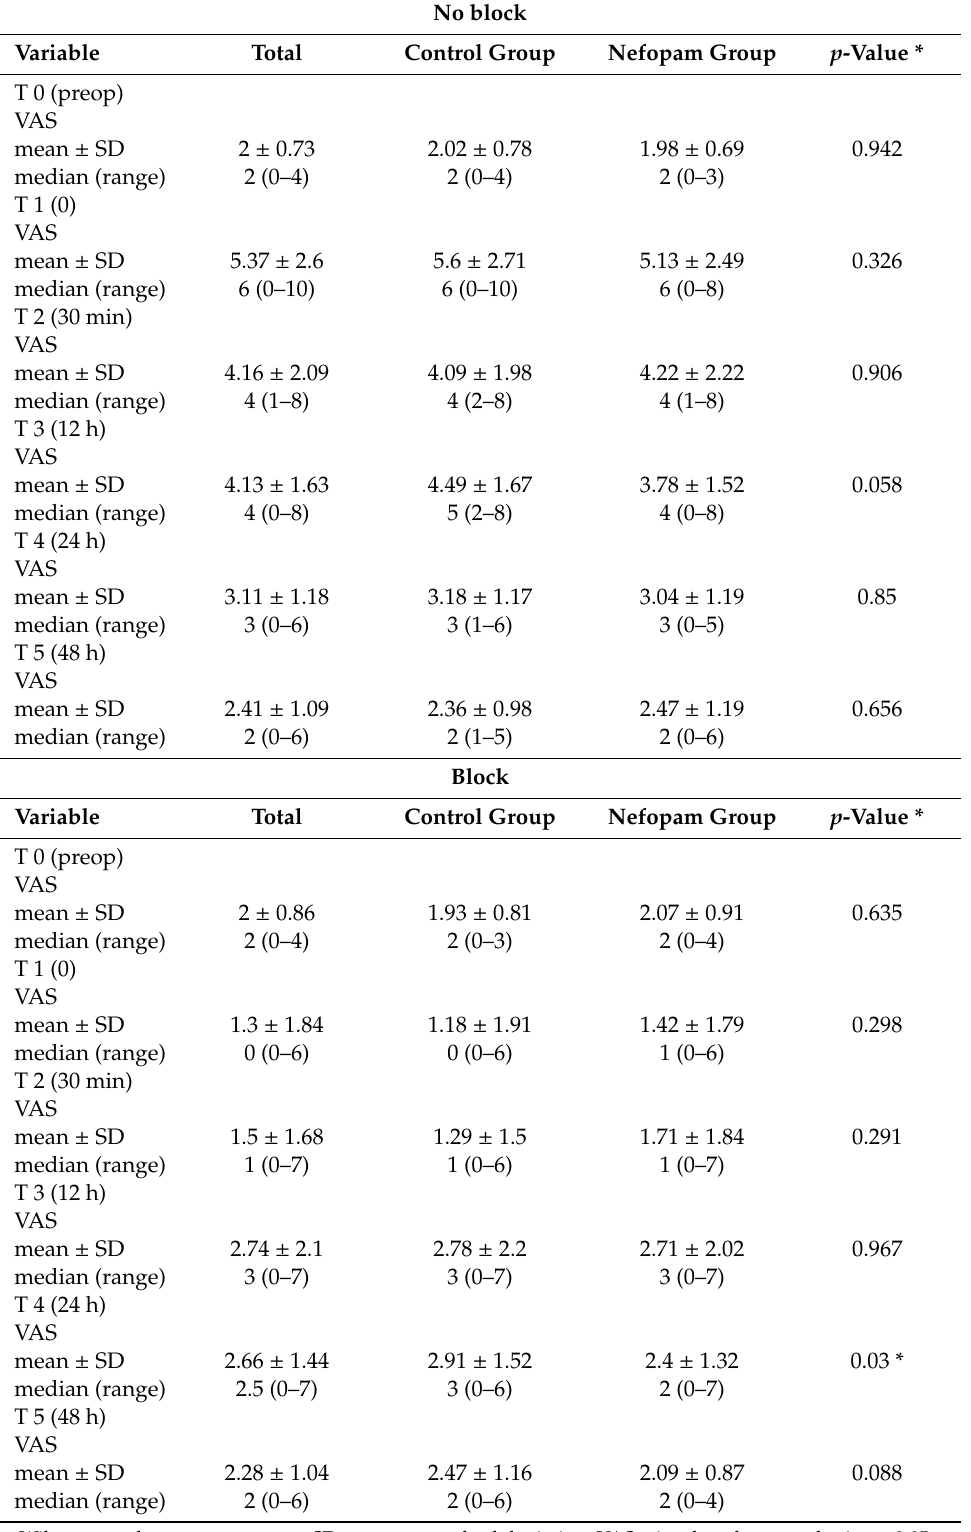
Table 4. Association in VAS between nefopam group and control group regarding